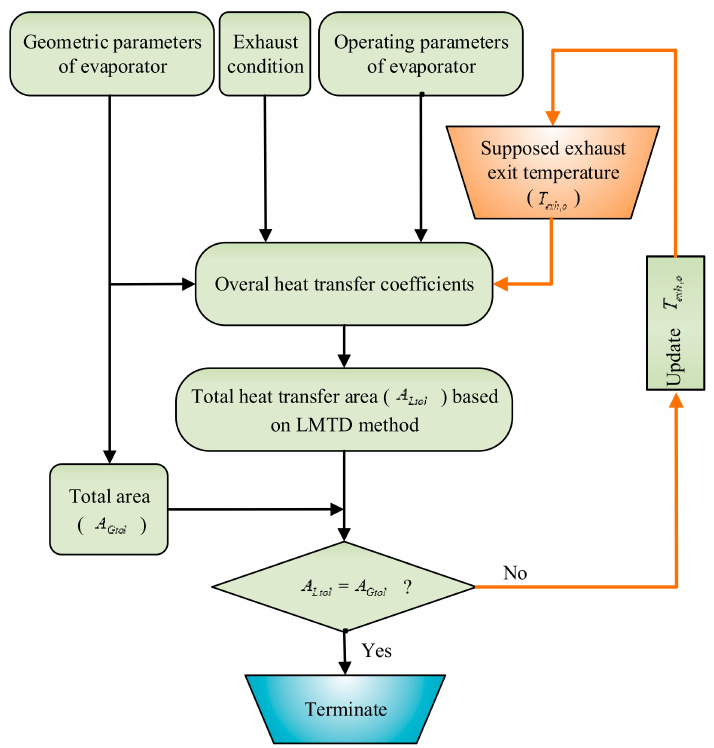
Figure 3. The flow chart of calculation for the heat exchanger (evaporator)